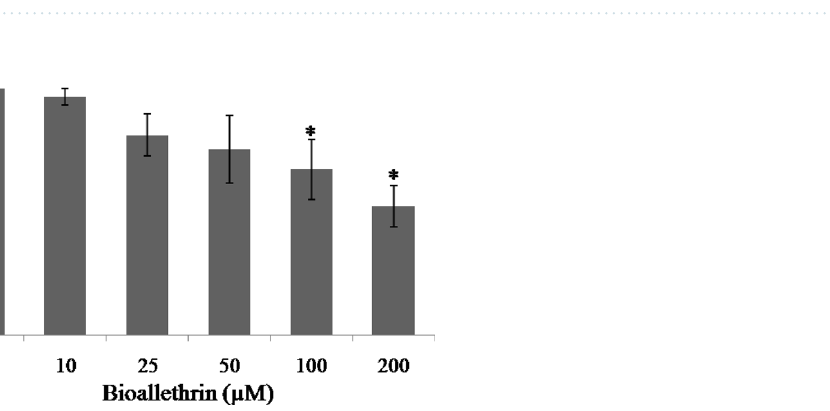
Figure 6. Scanning electron microscopy of lymphocytes. ( A ) Control (untreated) lymphocytes. Cells treated with ( B ) 50 µM ( C ) 100 µM and ( D ) 200 µM bioallethrin. Lymphocytes were incubated with bioallethrin for 2 h at 37 °C. Magnification is × 13,000 ( A , B ) and × 12,000 ( C , D ). Red arrows indicate the disrupted morphology of lymphocytes due to membrane damage.